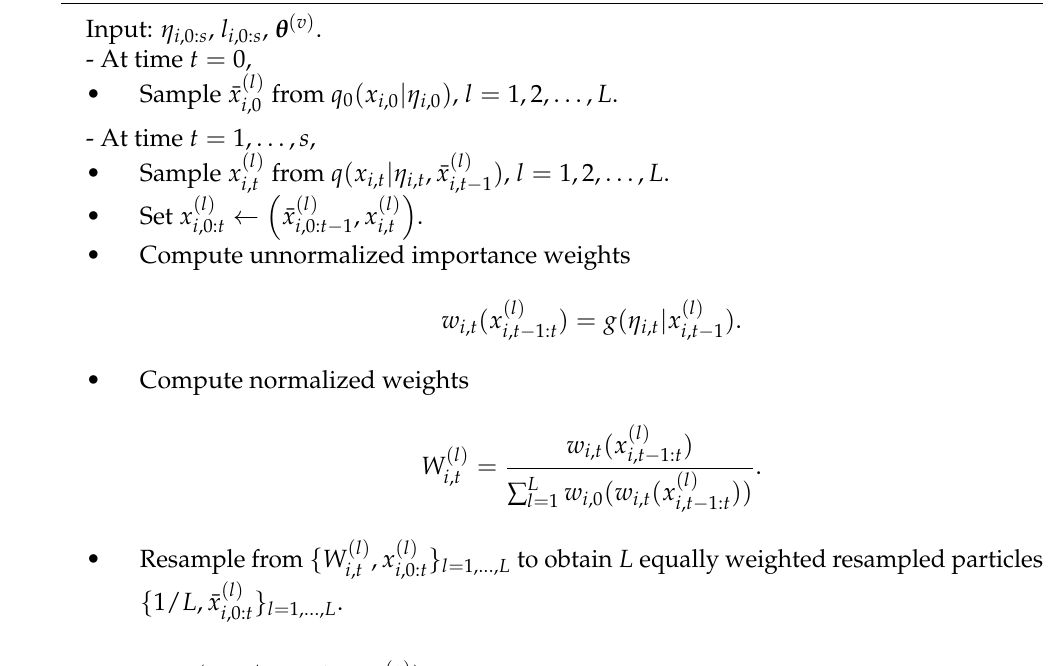
Algorithm 2 The SMC for filtering on workers in group i